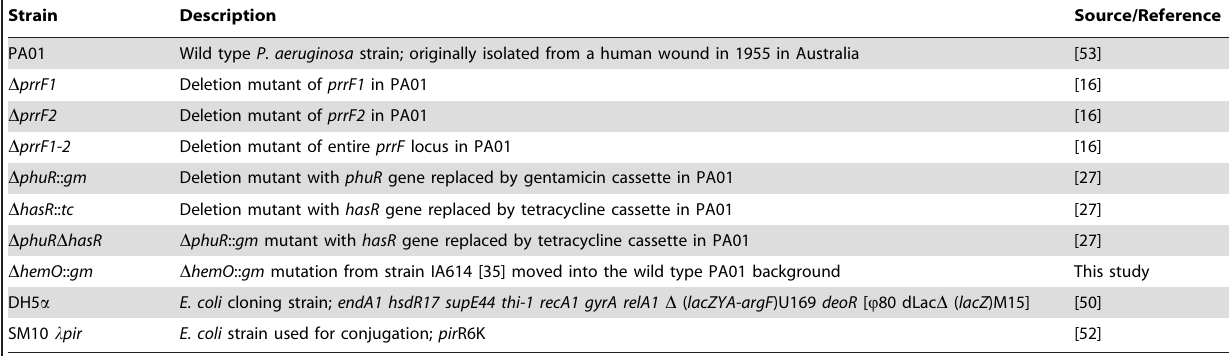
Table 1. Bacterial strains used in this